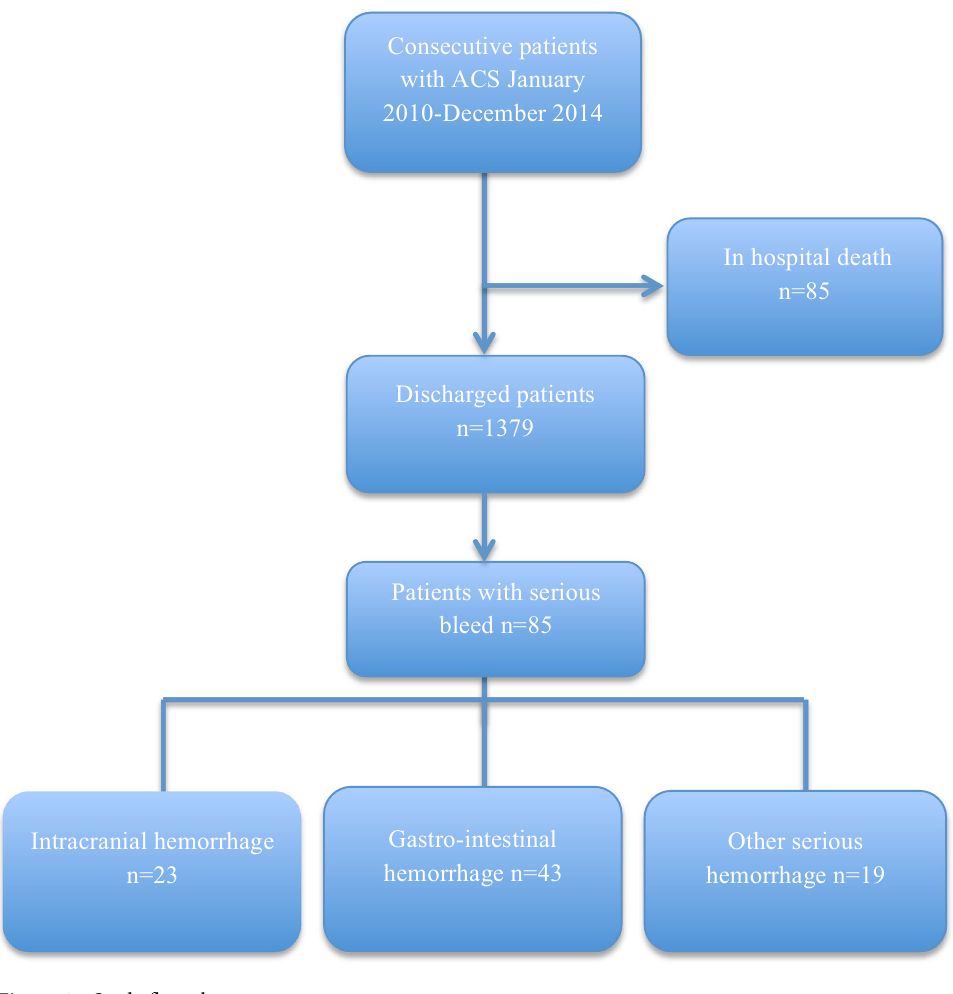
Figure 1. Study flow